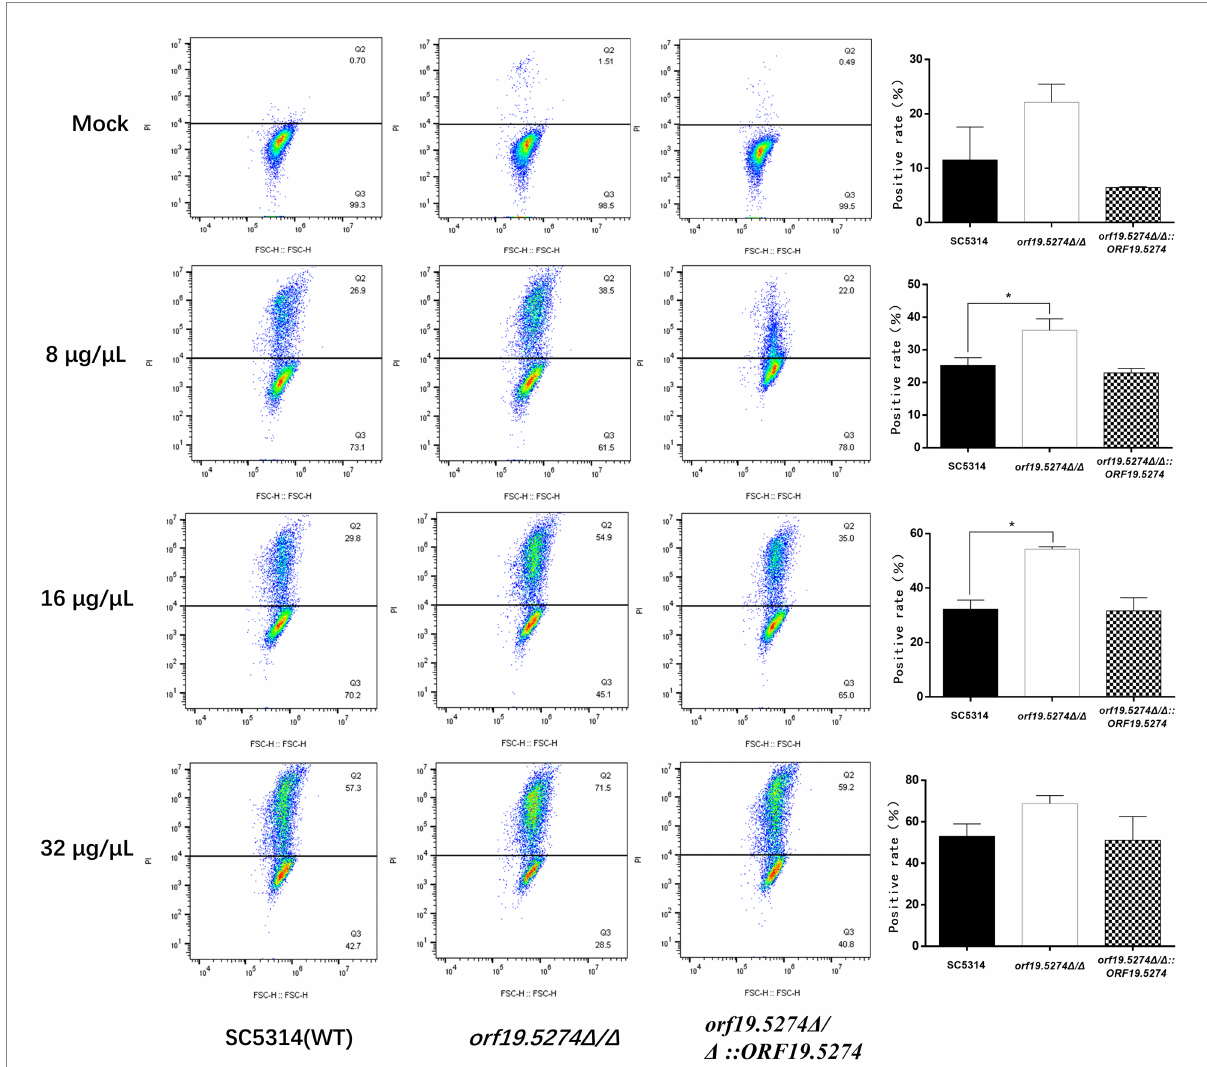
FIGURE 8 The effect of orf19.5274 Δ / Δ on the membrane permeability of Candida albicans cells. The ratio between gated cells and PI-positive cells in SC5314, orf19.5274 Δ / Δ , orf19.5274 Δ / Δ ::ORF19.5274 strains, respectively, without FLC treatment or with FLC